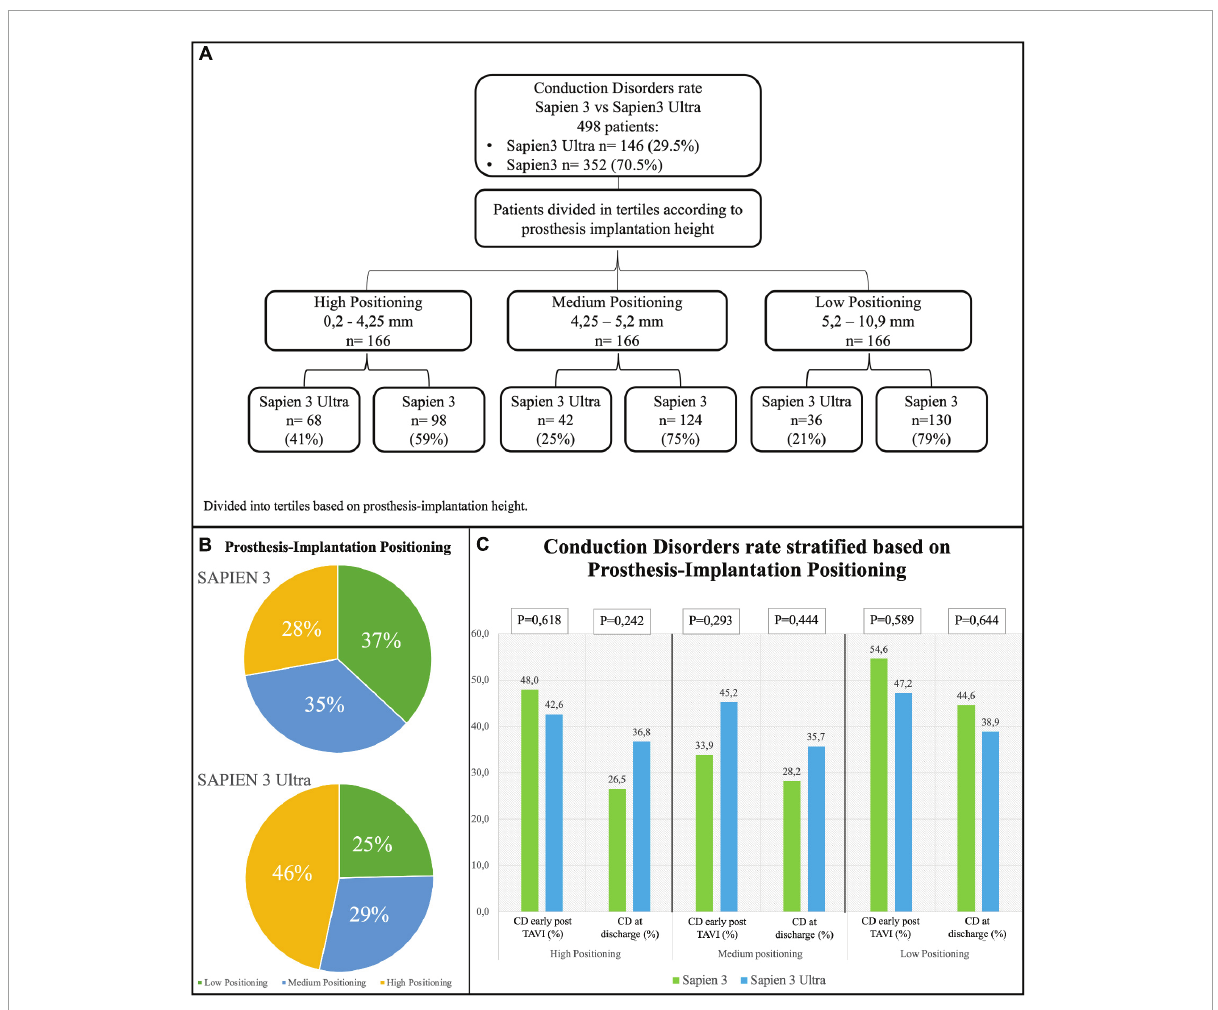
FIGURE5 Conduction disorders rate stratified based on prosthesis implantation depth. (A) Flowchart of stratification. Prosthesis implantation height was calculated by evaluating angiographic projections during the implantation. The population was then divided into tertiles. (B) Distribution of the study population based on valve implantation depth. (C) Rate of conduction disorders (CD) early after TAVI and at discharge based on prosthesis implantation